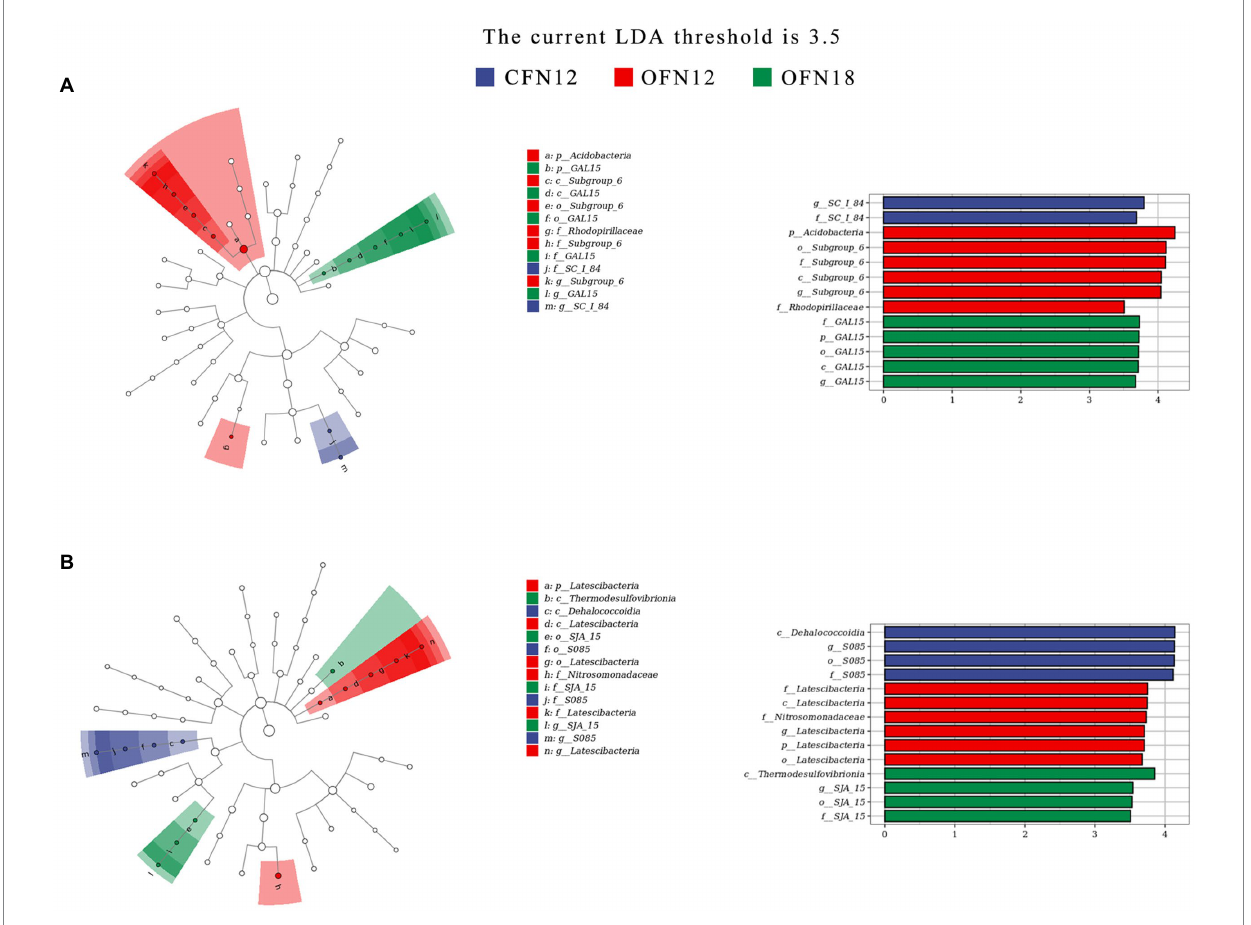
FIGURE 7 LEfSe analysis of bacterial community. (A) 0–10 cm; (B) 10–20 cm. p, phylum; c, class; o, order; f, family; g, genus.